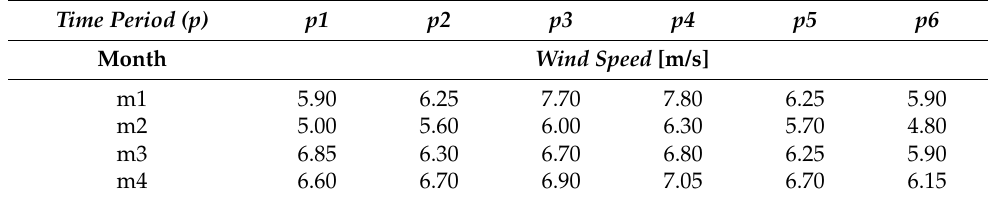
Table 3. UK wind speed data (adapted from